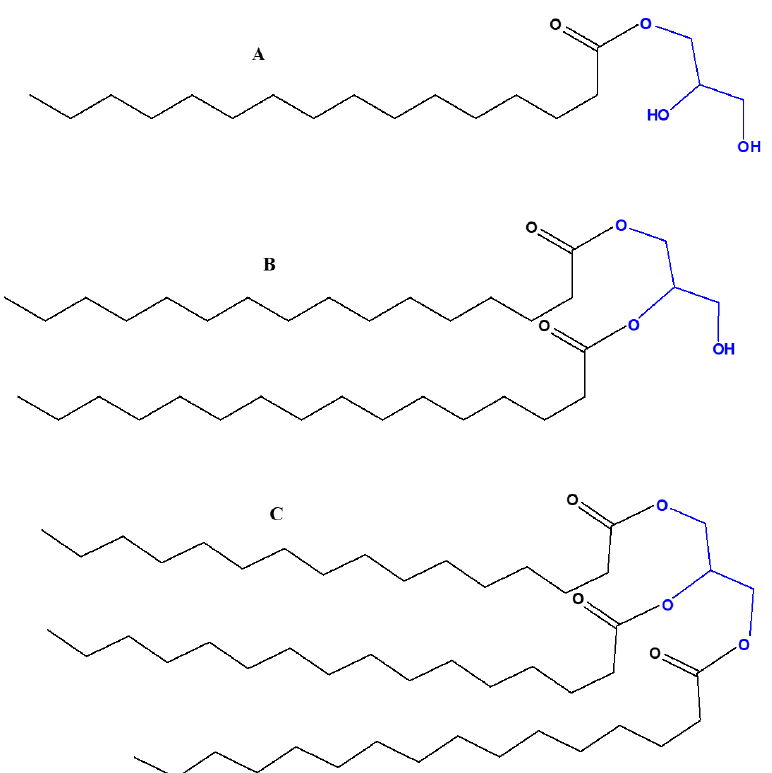
Figure 7. Various types of palmitoylglycerols obtained by heating ammonium palmitate with glyc- erol: ( A ) monopalmitoylglycerol, ( B ) dipalmitoylglycerol and ( C ) tripalmitoylglycerol, as discussed in [100]. Blue color shows glycerol linked with fatty acid chains through acylation.